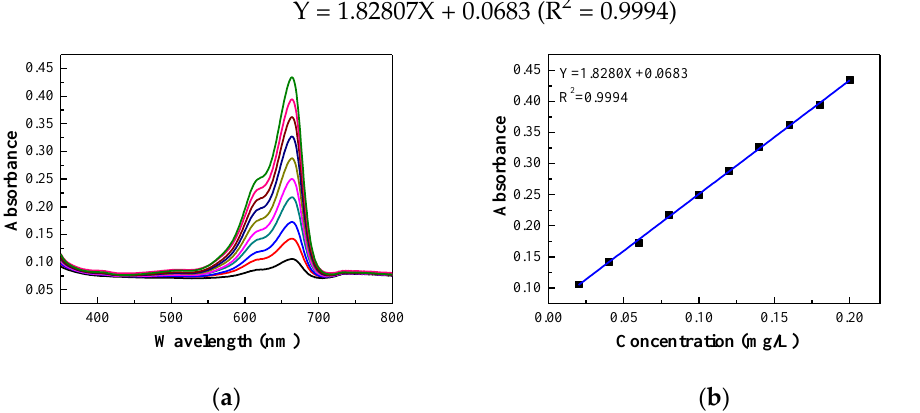
Figure 8. ( a ) UV–VIS spectra of MB solution with different concentrations. ( b ) MB standard solution concentration and absorbance fitting curve.